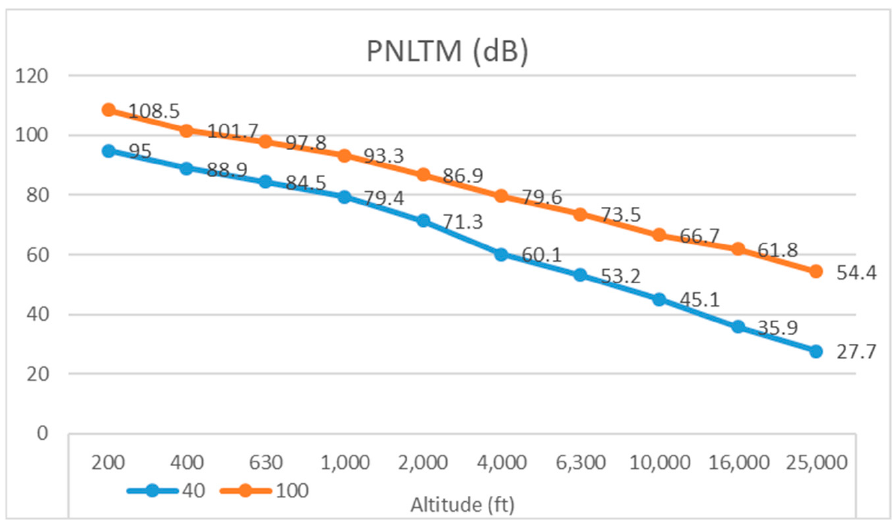
Figure 33. NPD curves, in terms of PNLTM, for the ATR configuration.